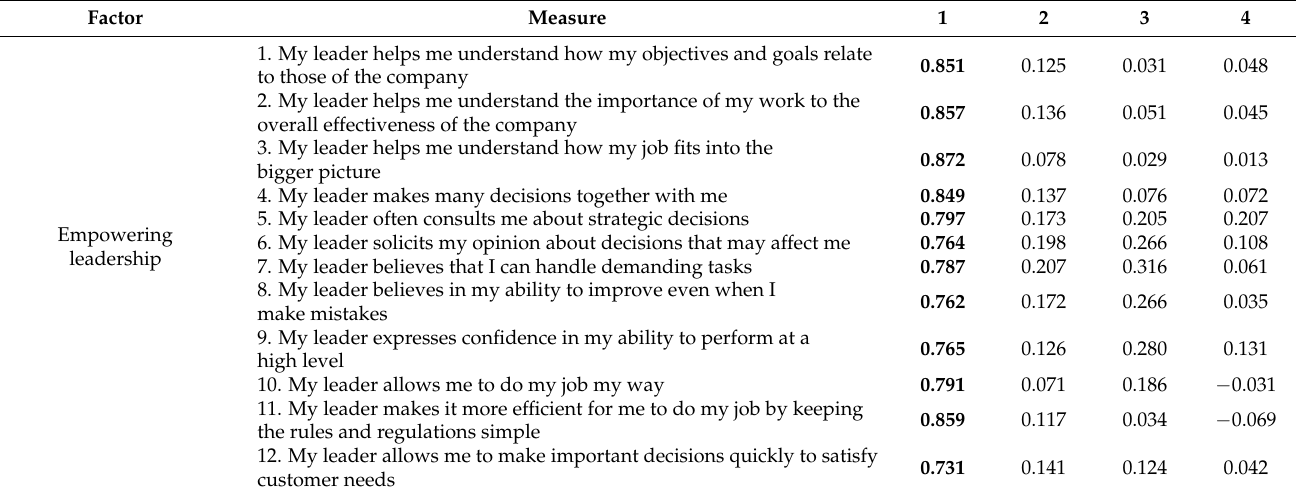
Table 2. Exploratory factor analysis and reliability